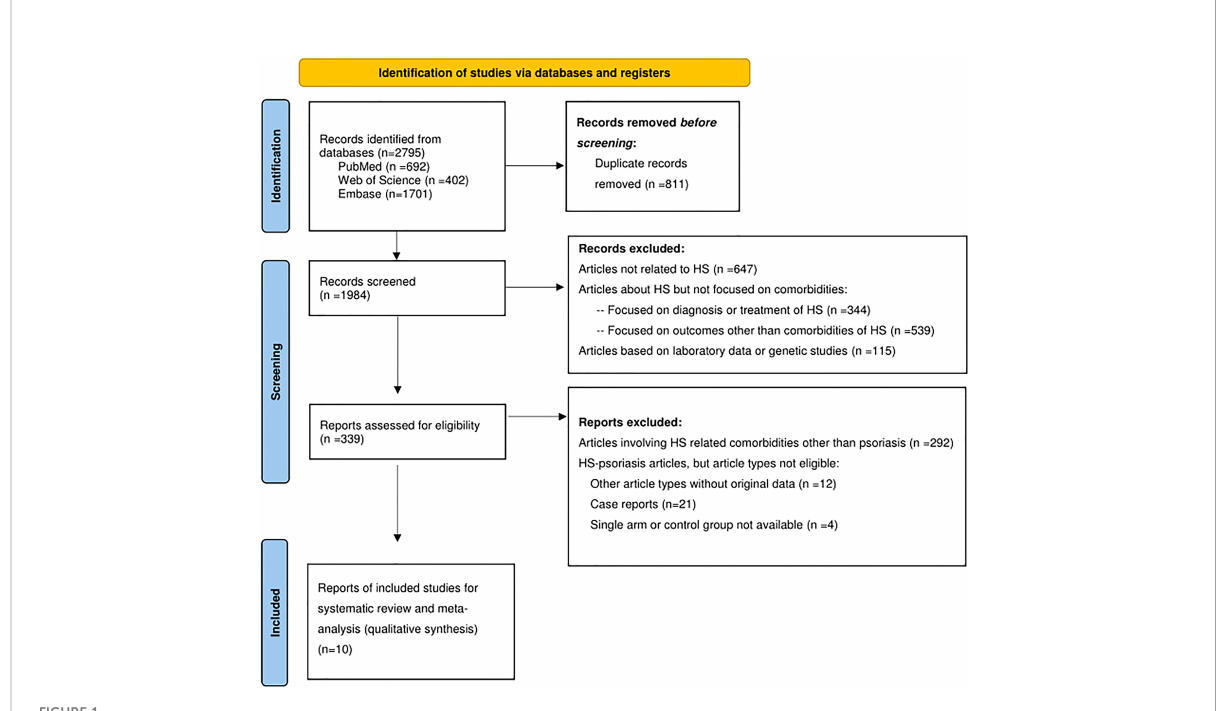
FIGURE 1 PRISMA study fl